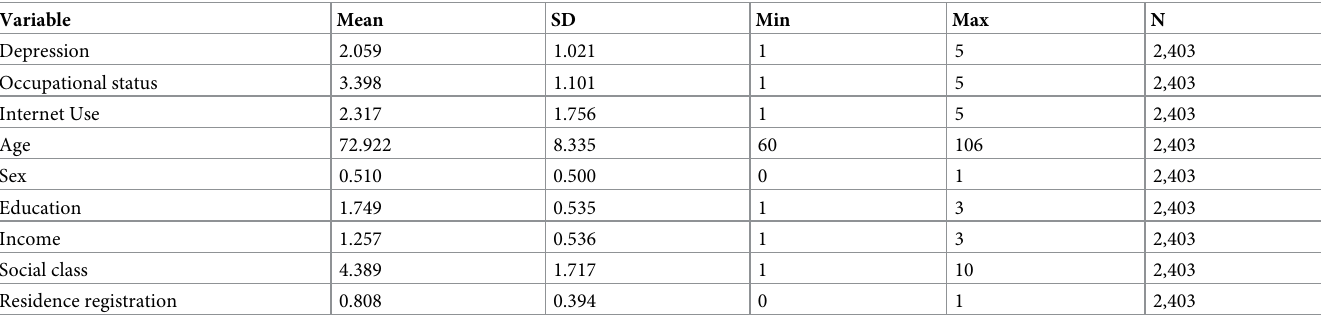
Table 1. Descriptive statistics of respondents (N =